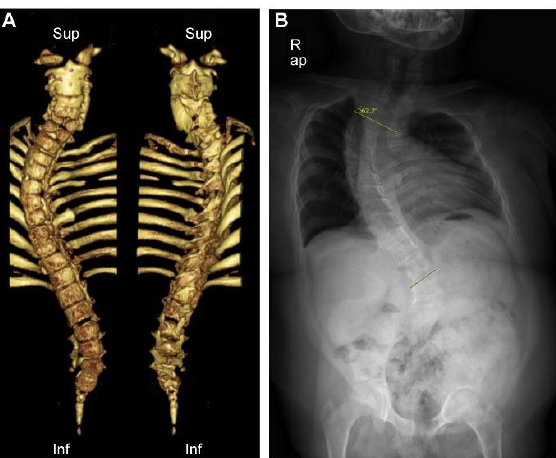
Figure 1. Three-dimensional computed tomography and plain radiography of the whole spine. ( A ) Multiple anomalies of the spine and the sacrum, including fusion of C2/3, C4/5 vertebra, butterfly vertebra of C5 to C7, dysraphism of C1, C5, C6, and T8, and hypogenesis of the sacrum, were notable. ( B ) Severe scoliosis of Cobb angle of 62°, decreased number of ribs, and downward tilt of ischiopubic rami were identified.